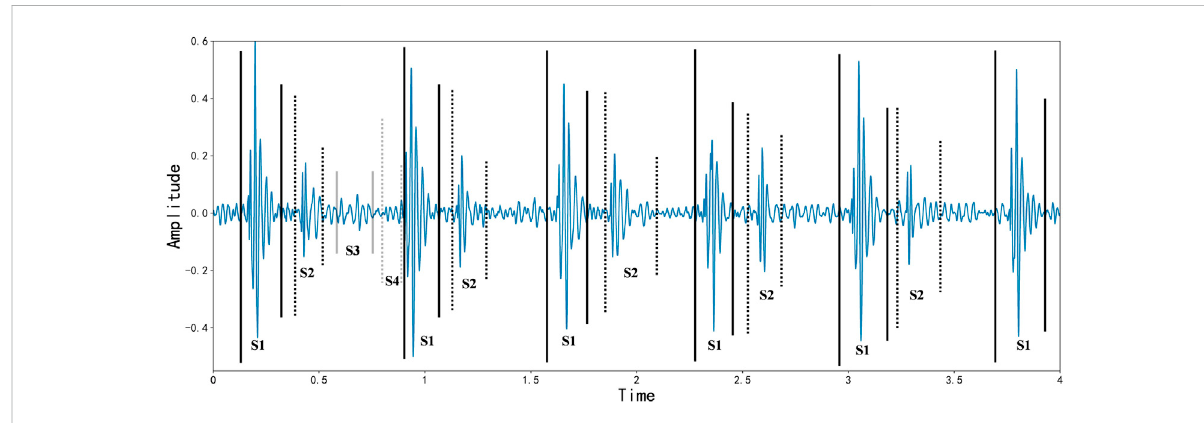
FIGURE 2 Waveform representation of S1, S2, S3, and S4 sounds in systole and diastole intervals, as of Varghees and Ramachandran